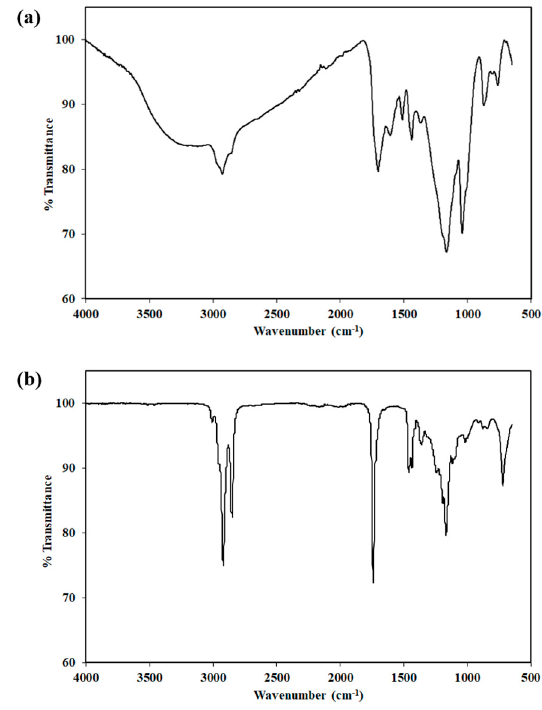
Figure 3. FT-IR spectra of ( a ) SCG-lignin and ( b ) SCG-FAME.